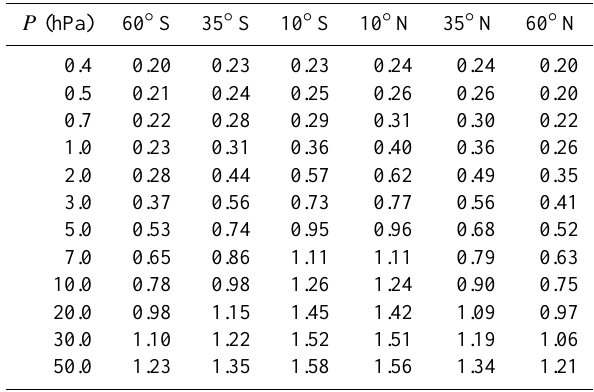
Table 2. Mean CH 4 mixing ratio profiles